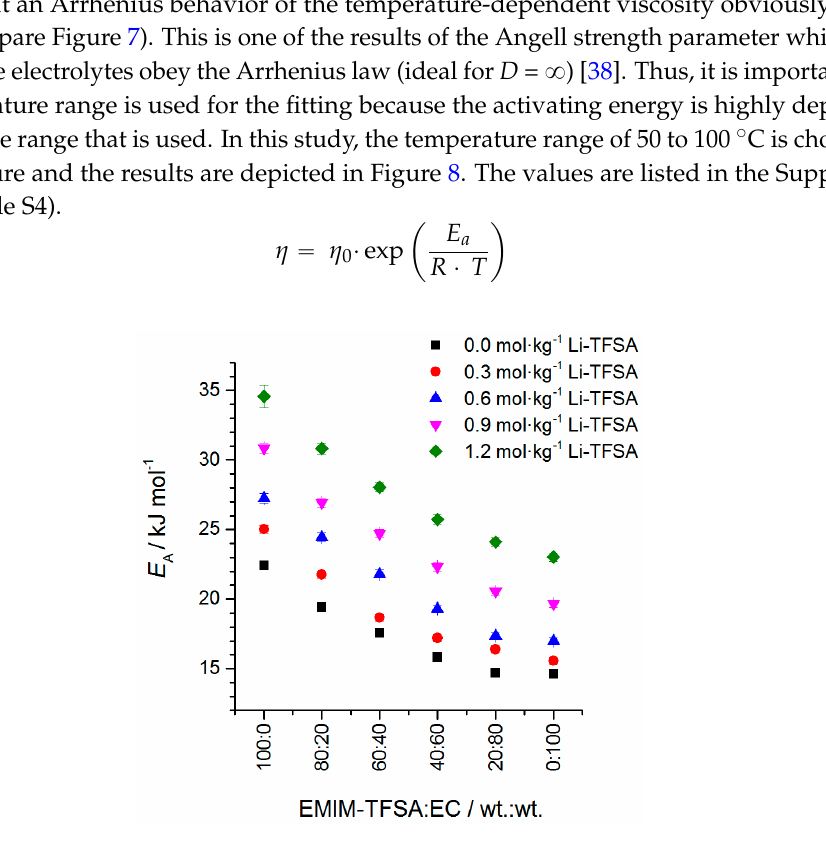
Figure 8. Activation energy of the flow process according to Arrhenius plotting in the temperature range of 50–100 °C ( Ṝ 2 = 0.991).